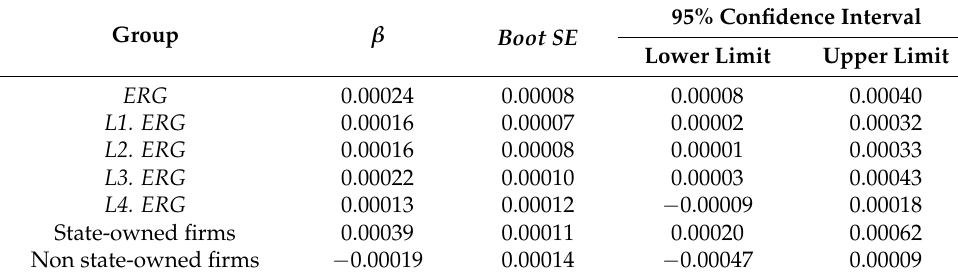
Table 9. The bootstrap robustness tests. Group β Boot SE